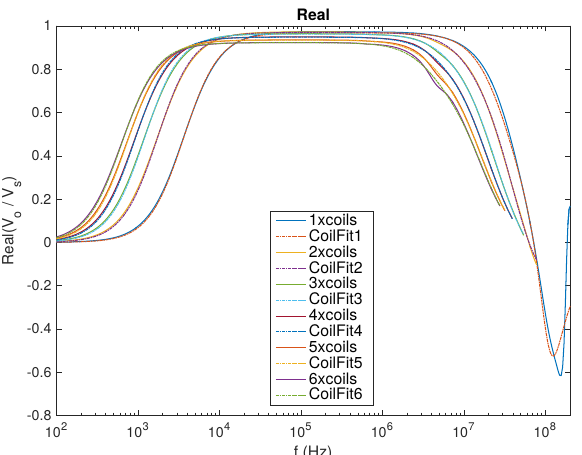
Figure 11. Fits (dash-dot lines) and data (continuous lines) of the real part of the transfer function of the circuit configuration of Figure 8 and Equation (9) when the number of transformers connected in series varies from one to six.